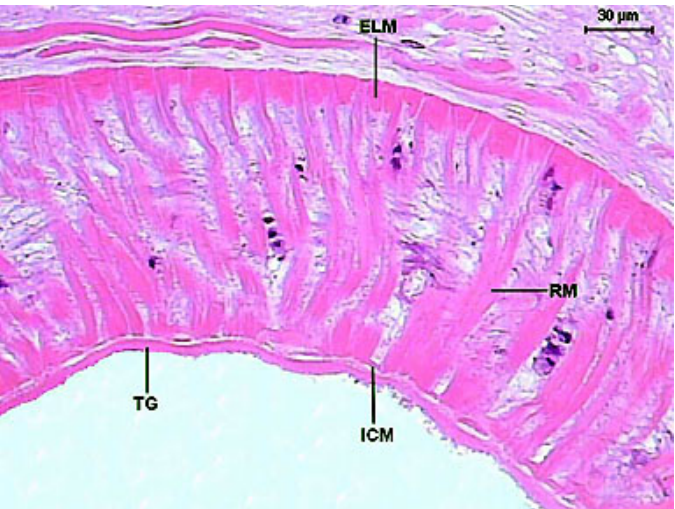
Figure 14. Detail of the Sticholecitha serpentis acetabulum. ELM – external longitudinal musculature, ICM – internal circular musculature, RM – radial musculature, TG – tegument. HE.